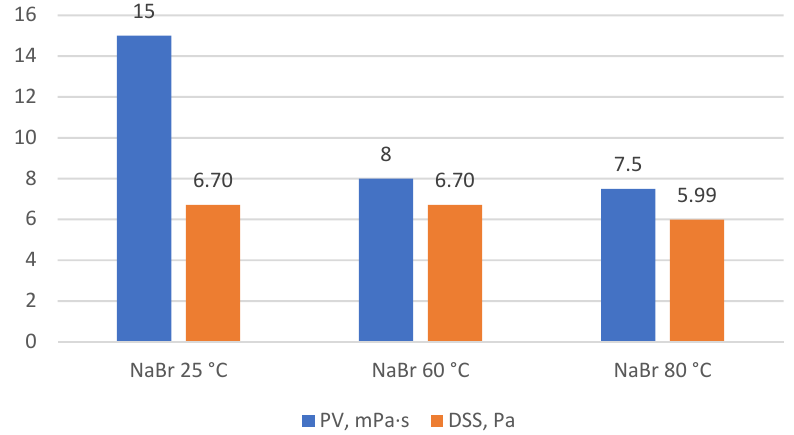
Figure 5. Plastic viscosity (PV) and dynamic shear stress (DSS) of NaBr-based drilling mud at different temperatures.